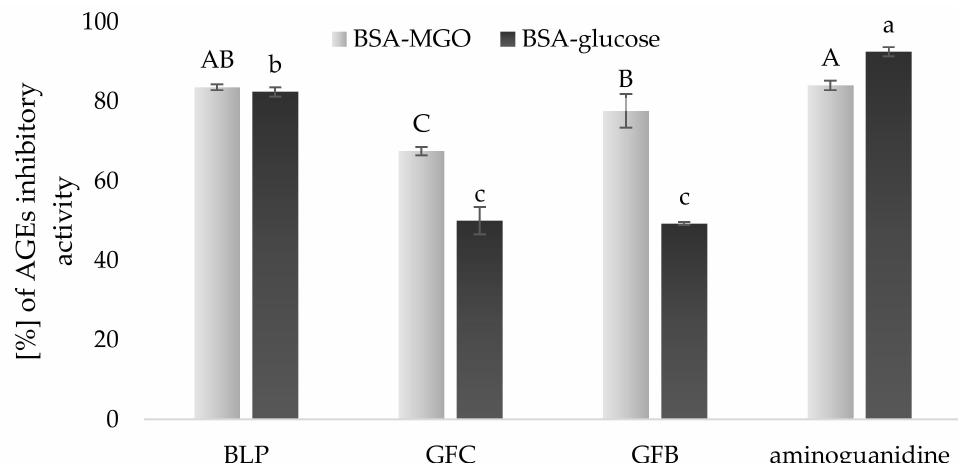
Figure 2. Results of anti- advanced glycation end-products (AGE) activity in models of bovine serum albumin-methylglyoxal (BSA-MGO) and BSA-glucose in samples of broccoli leaf powder (BLP), control gluten-free bread (GFC), and gluten-free bread enriched with broccoli leaf powder (GFB). The results are presented as the mean ± SD ( N = 3). Bars with different letters denote significant differences ( p < 0.05) when subjected to Tukey’s